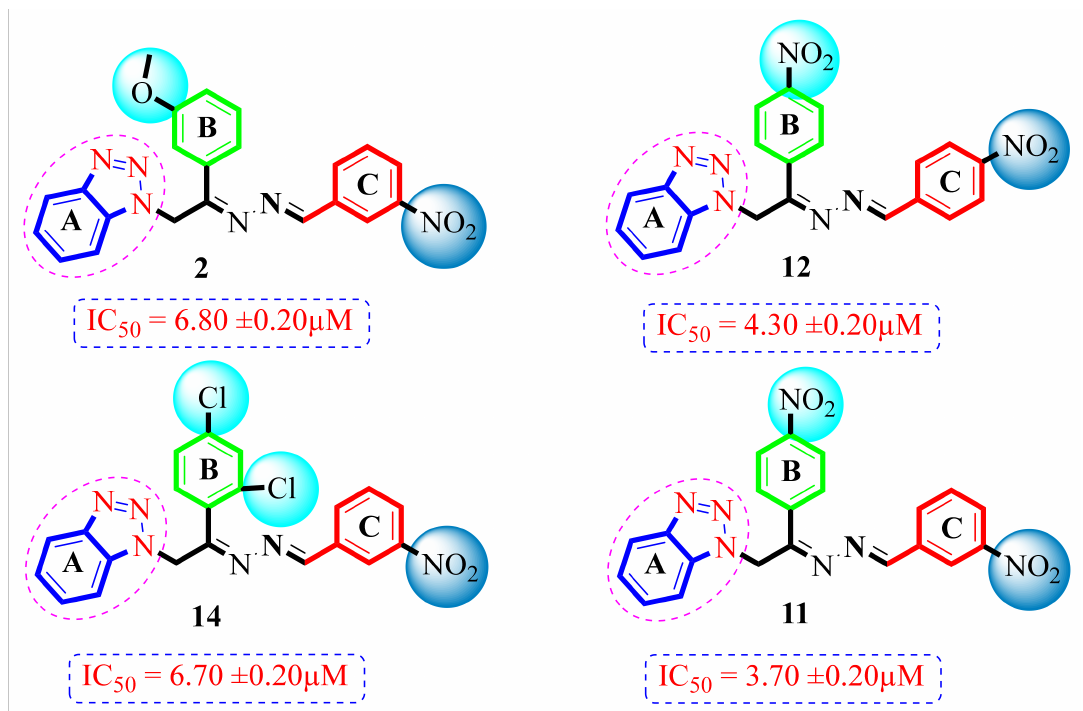
Figure 4. SAR study of analogs 2 , 11 , 12, and 14